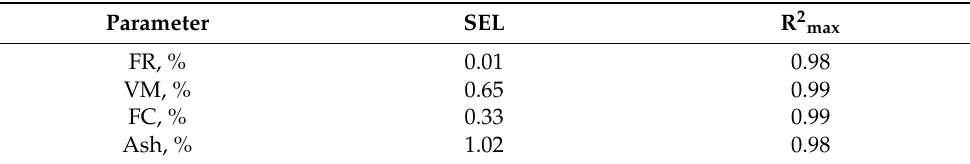
Table 2. The standard error of laboratory (SEL) and maximum coefficient of determination (R 2 max ) of fuel ratio (FR), volatile matter (VM), fixed carbon (FC), and ash (A).